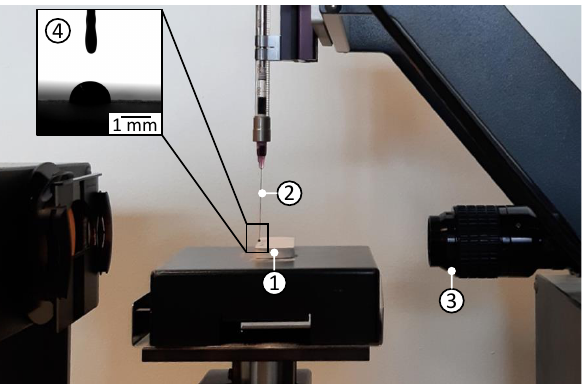
Figure 6. Experimental setup of the sessile drop method with the powder bed in a vessel (1), the needle for the drop formation (2), and an image section (4) of the camera shots (3) for the evaluation of the powder–ink